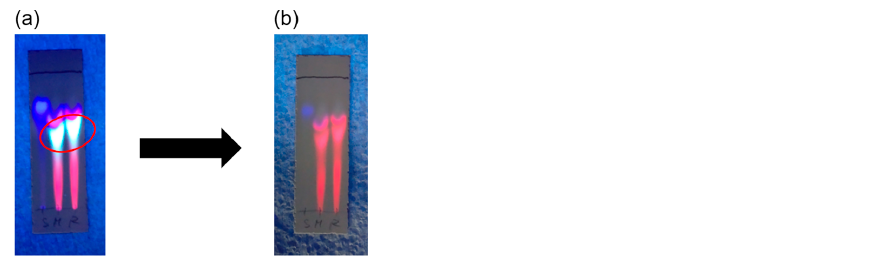
Figure 1. TLC images. Photos taken under irradiation with ultraviolet light at a 365 nm wavelength of a TLC plate obtained after conducting a TLC experiment of the reaction between 3-( N,N -dime- thylamino)phenylboronic acid and 4-formylbenzoic acid (developing solvent: CH 3 OH). The photo in ( a ) is of the TLC plate immediately after development (the red circle indicates the spots due to reduced BRhoC), and the photo in ( b ) is of the same plate after 5 min exposure to the light of an ordinary fluorescent